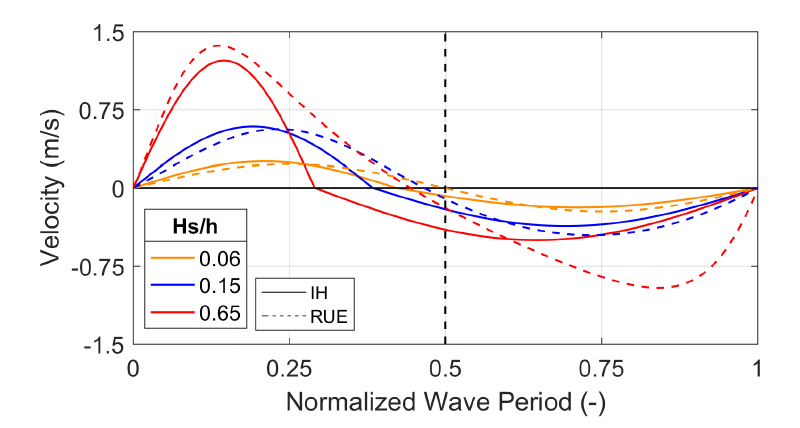
Figure 4. Intra-wave velocity profile (wave shape) computed at Duck with IH and RUE along different profile locations from deep (orange) to shallow (red) water represented by the ratio of wave height divided by water depth H s / h . Positive velocities are